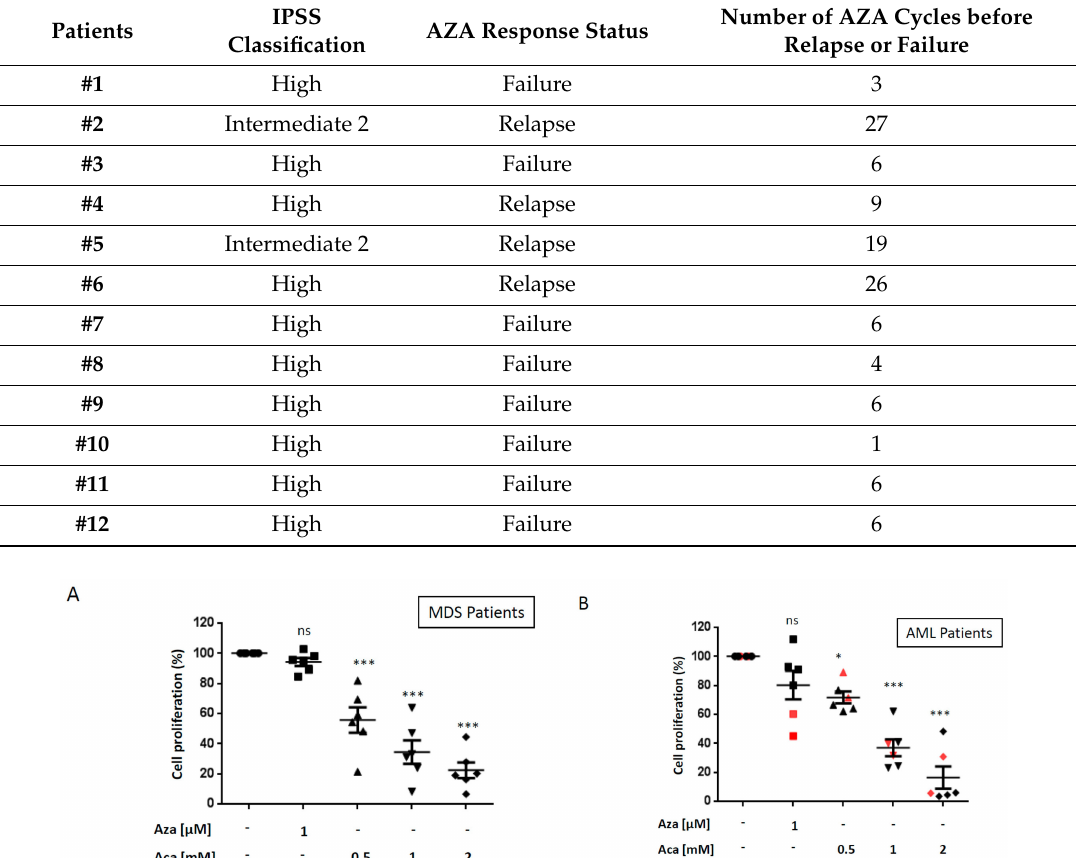
Figure 3. Aca exerts potent anti-leukemic e ff ect in MDS and AML bone marrow cell ex vivo.